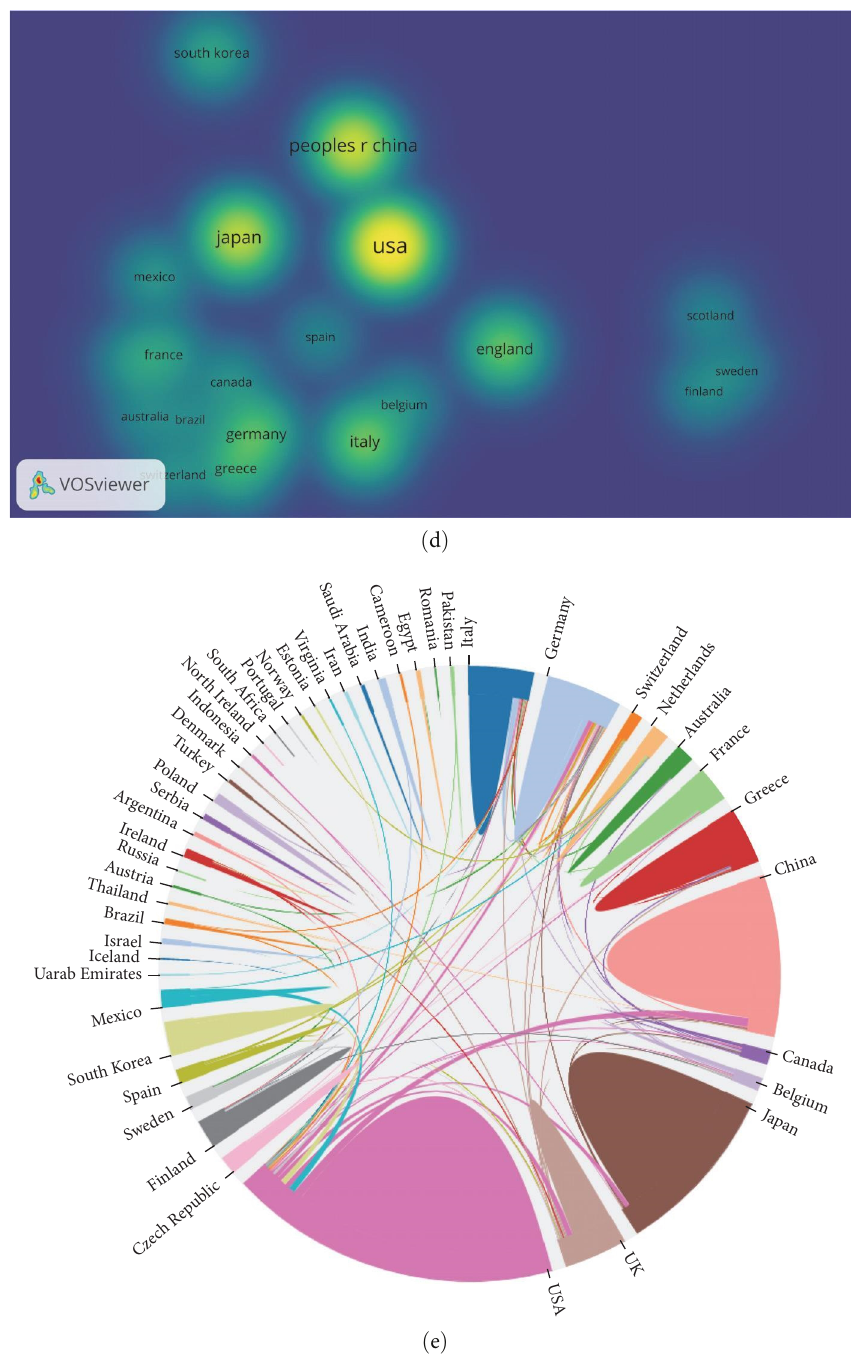
F IGURE 3: Contributions of different countries/regions in the fi eld of IPF and immune response. (a) The number of publications, total number of citations ( × 0.01), and H-index ( × 2) in the top 15 countries/regions. (b) Map of the international cooperation network of the top 20 countries/regions. The circle size represents the number of publications. (c) Countries/regions were colored based on the average publication time. Blue color represents early years, and yellow color represents more recently. (d) The thermodynamic chart of countries/ regions weight in this fi eld established using VOSviewer. (e) A pie chart of the contributions and cooperation of different countries/regions established using the bibliometrics online